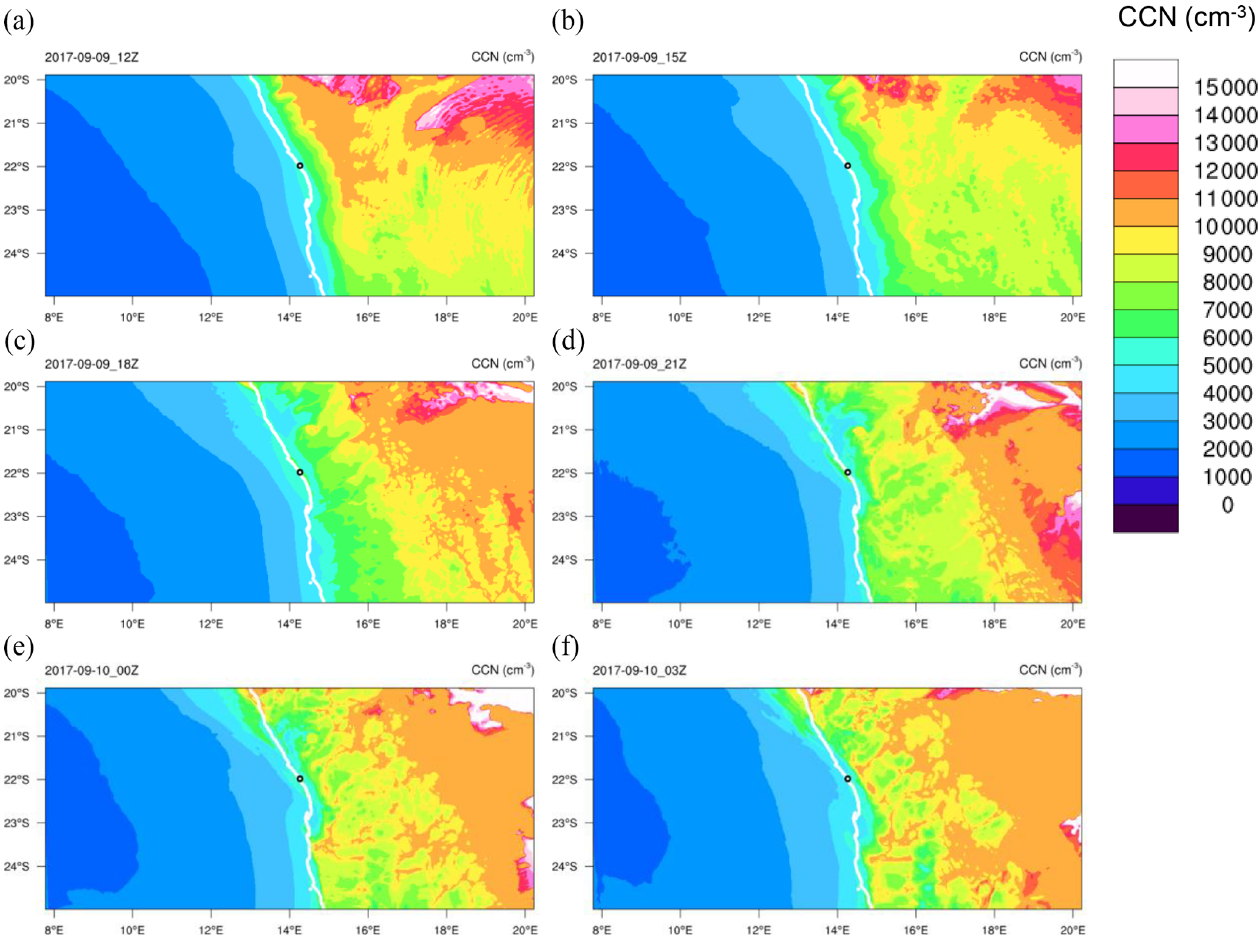
Figure 14. Evolution of CCN concentration for the event on 10 September 2017 for scenario CCN_C10. The black dot is Henties